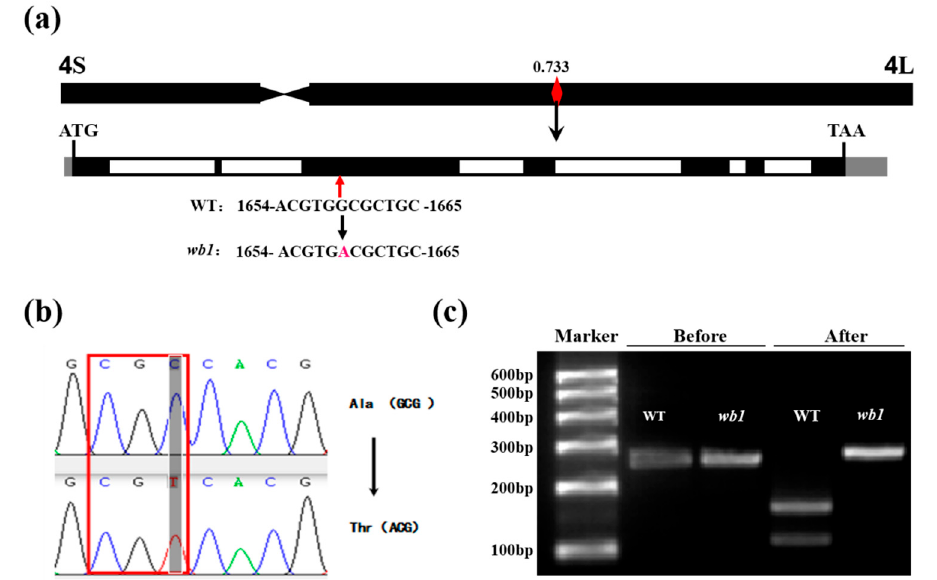
Figure 5. Further verification of causal SNP in wb1 . ( a , b ) Sequencing validation of the causal SNP and the type of mutation; the red arrow indicates the mutant site, and the black arrows indicate the alternations; ( c ) Digestion of restriction endonuclease Hae II. “Before” represents the non-treated PCR product and “After” represents the Hae II-treated PCR product.